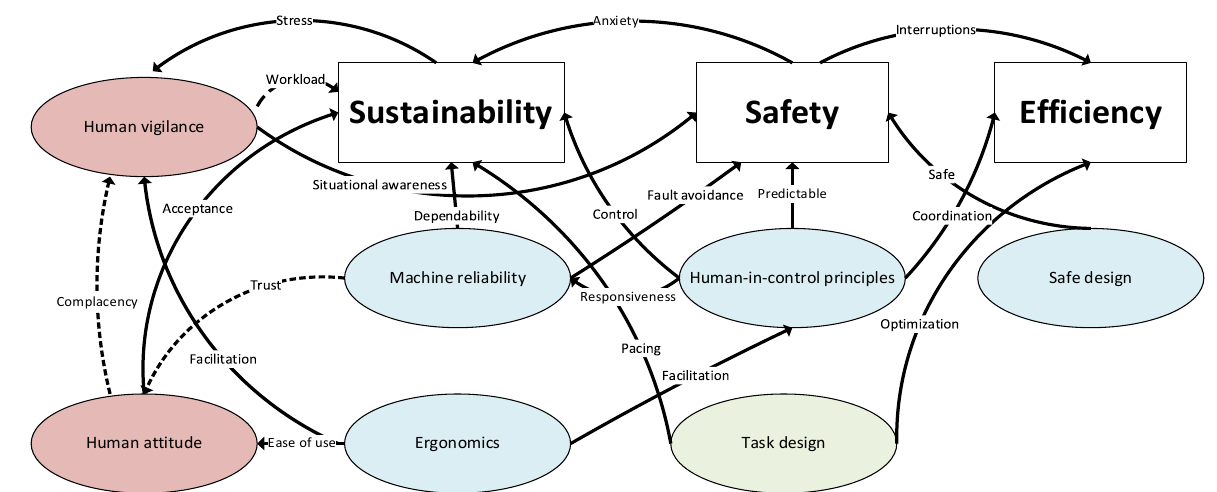
Figure 2. Visualization of the clusters and relationships of the final model, as listed in Table 4. Red concerns human clusters, blue are technological clusters, green is the organizational cluster, and white are the output clusters.